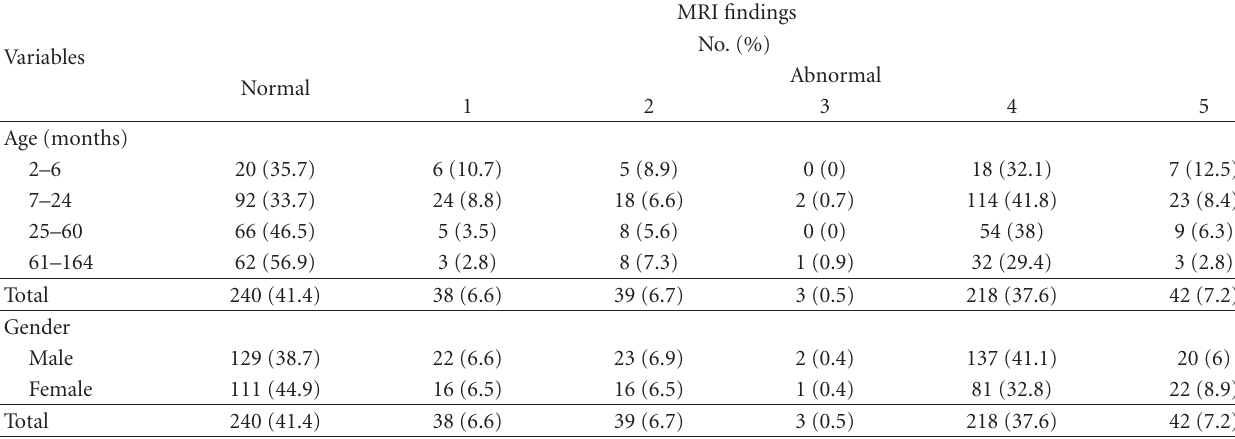
Table 1: MRI findings in study groups based on age and gender variables.